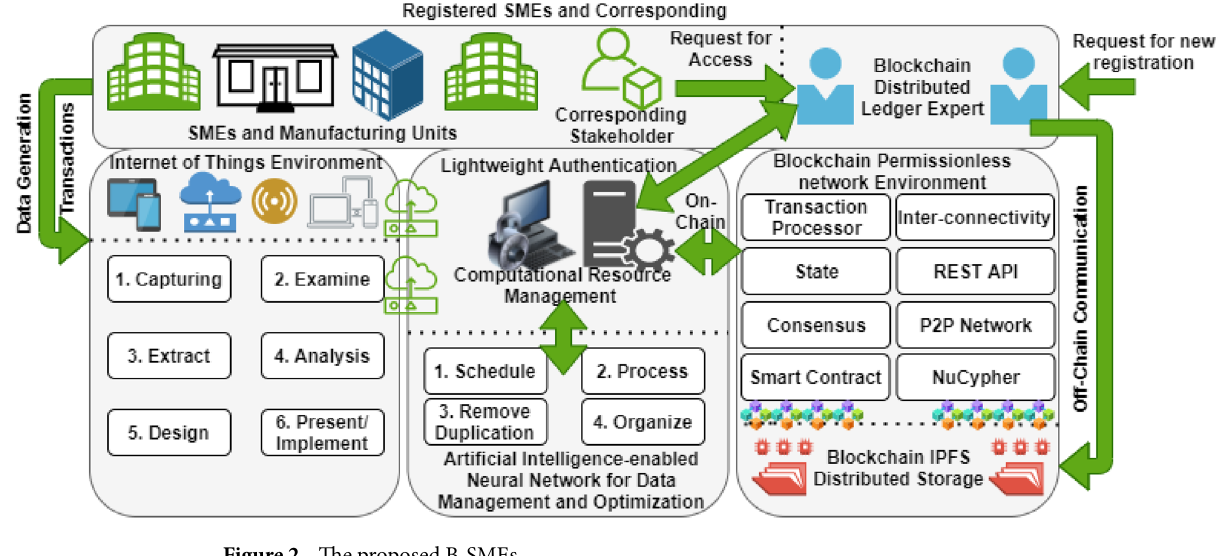
Figure 2. The proposed